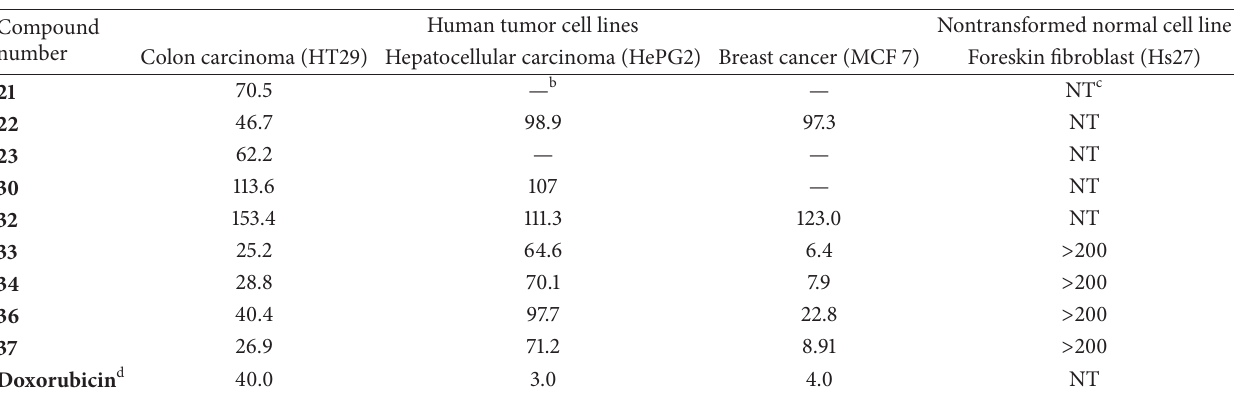
Table 1: Cytotoxic effects LC 50 ( 𝜇 M) a of the active compounds on three human tumor and nontransformed cell lines and using the MTT